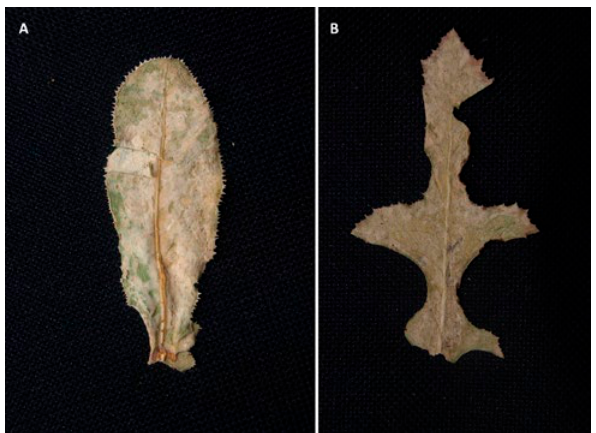
Figure 1. Symptoms of powdery mildew infections on lower sides of leaves of A, Lactuca serriola f. integrifolia , and B, L. serriola f. ser- riola